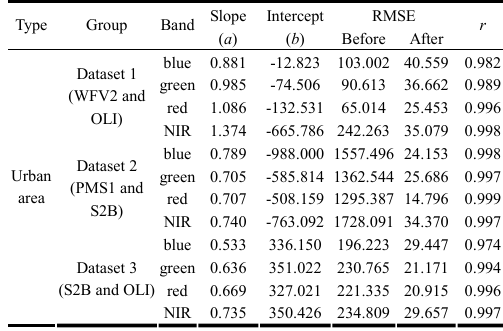
Table 7. Quantitative validation of urban area study area